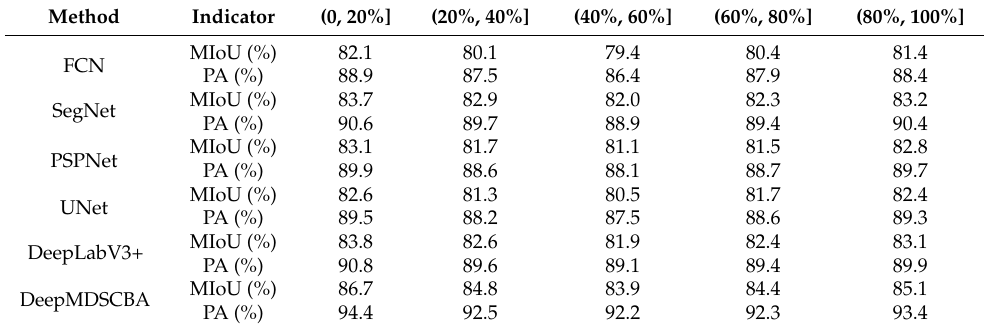
Table 8. Segmentation performance of apple images with different rot degrees.